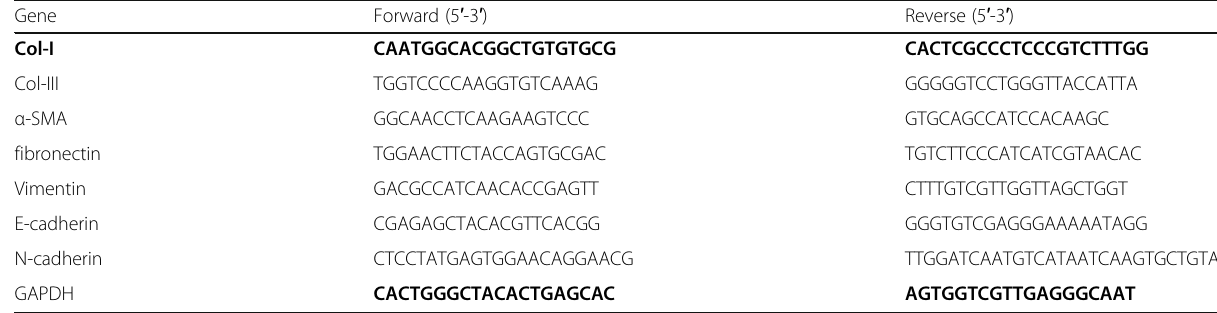
Table 1 Primer base